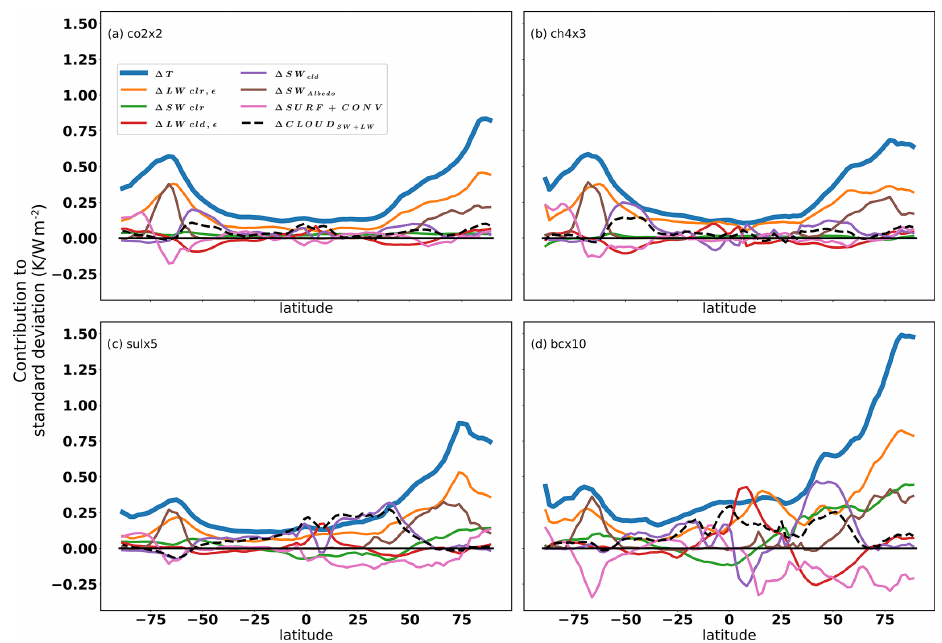
Figure 7. Zonal mean of the total standard deviation of the effective temperature response (thick blue line) and the contributions of the different energy balance terms to it (thin lines; see the legend in a ). Panel (a) shows co2x2, panel (b) shows ch4x3, panel (c) shows sulx5, and panel (d) shows